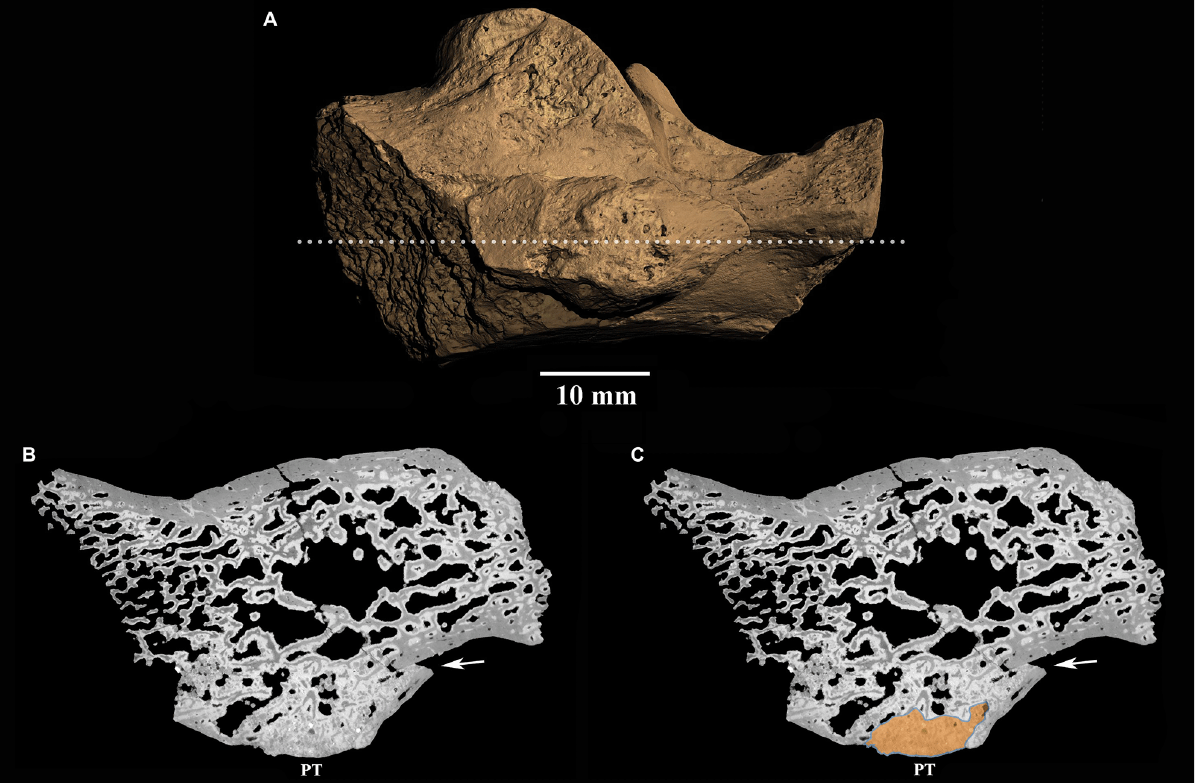
Figure 4: (A) Lateral view of StW 352 with the dotted line indicating the location of the transverse section through the middle of the peroneal trochlea (PT). (B) MicroCT image showing internal structure of the PT. Arrow indicates the area in which evidence of misalignment is best visualised. Note the presence of matrix infill located above the ‘PT’ label. (C) Repeat of image B with the shaded area demarking the approximate extent of the matrix